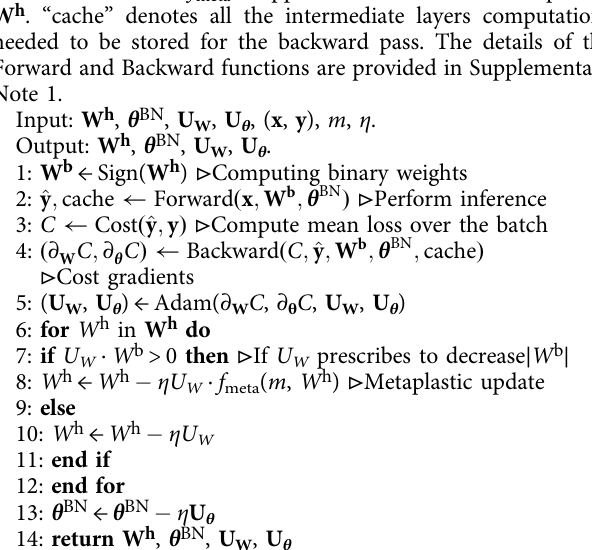
Algorithm 1 Our modi fi cation of the BNN training